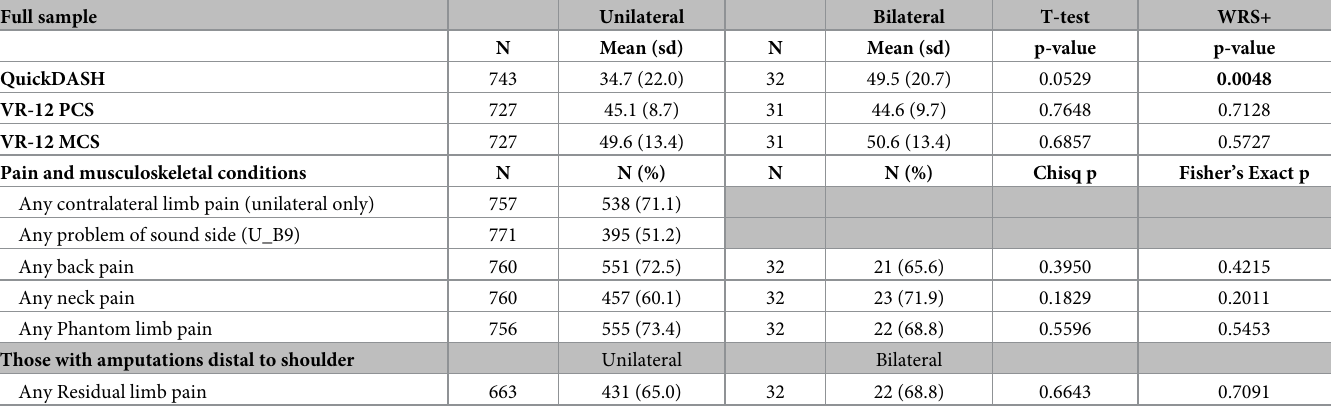
Table 6. Disability and quality of